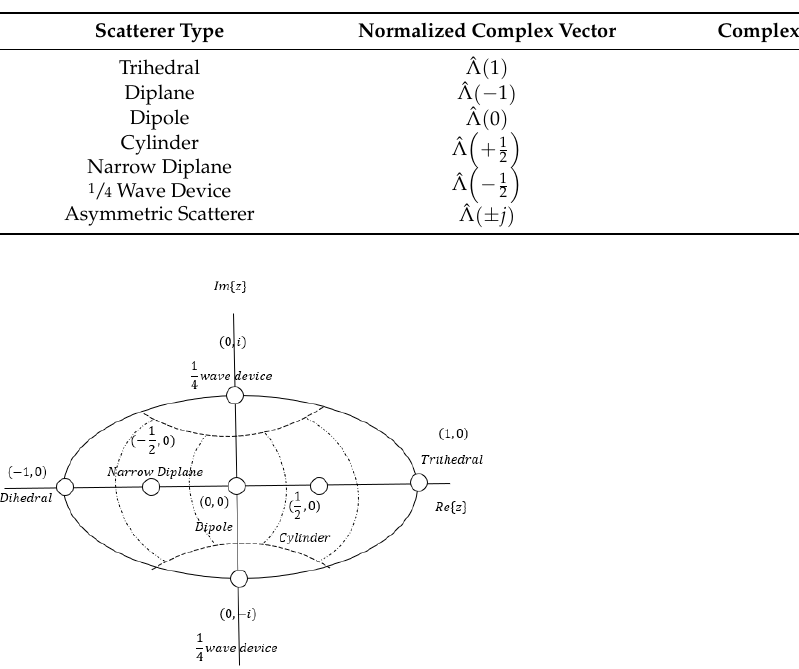
Table 1. Cameron’s scattering mechanisms.